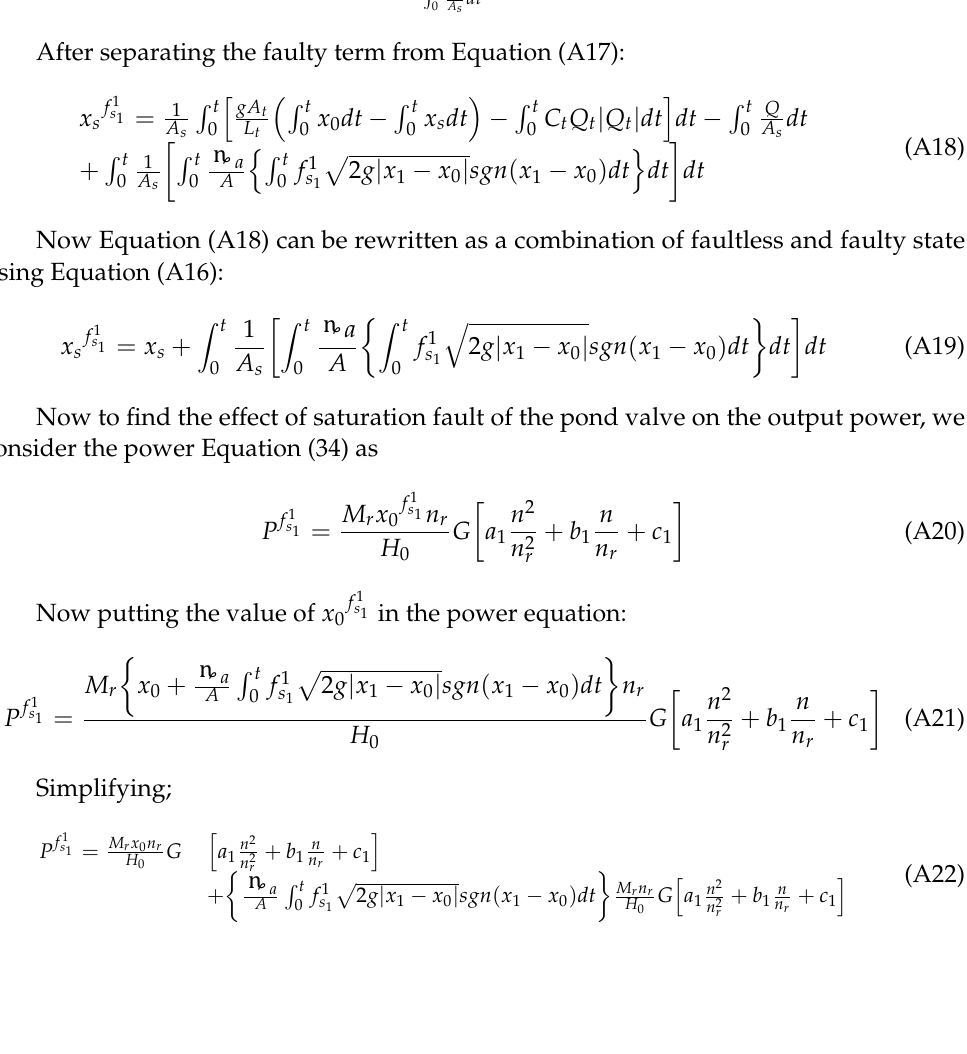
Figure 1. Three-pond hydraulic system.